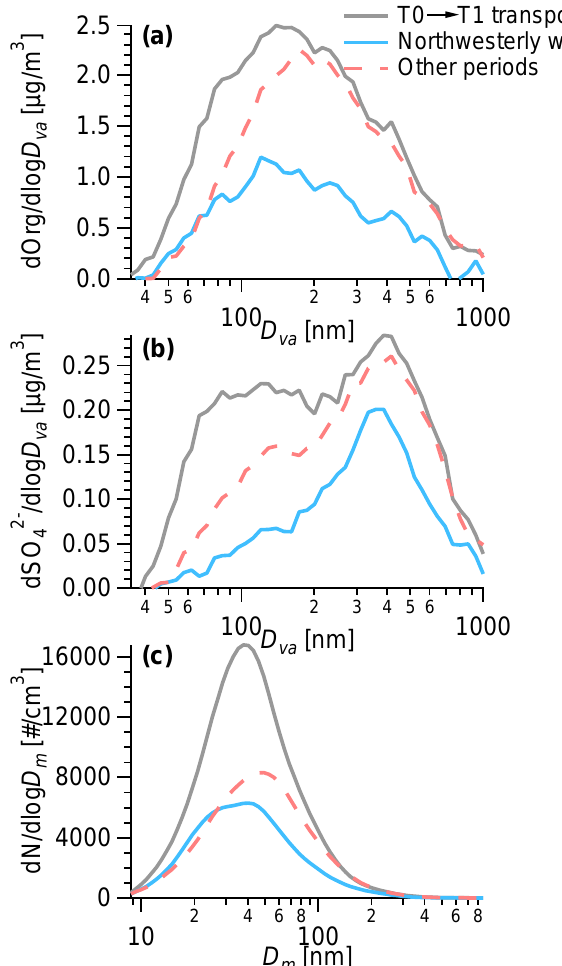
Fig. 13. Comparison of the average size distributions of (a) organ- ics, (b) sulfate and (c) particle number concentration between the three air mass categories as marked on Fig.